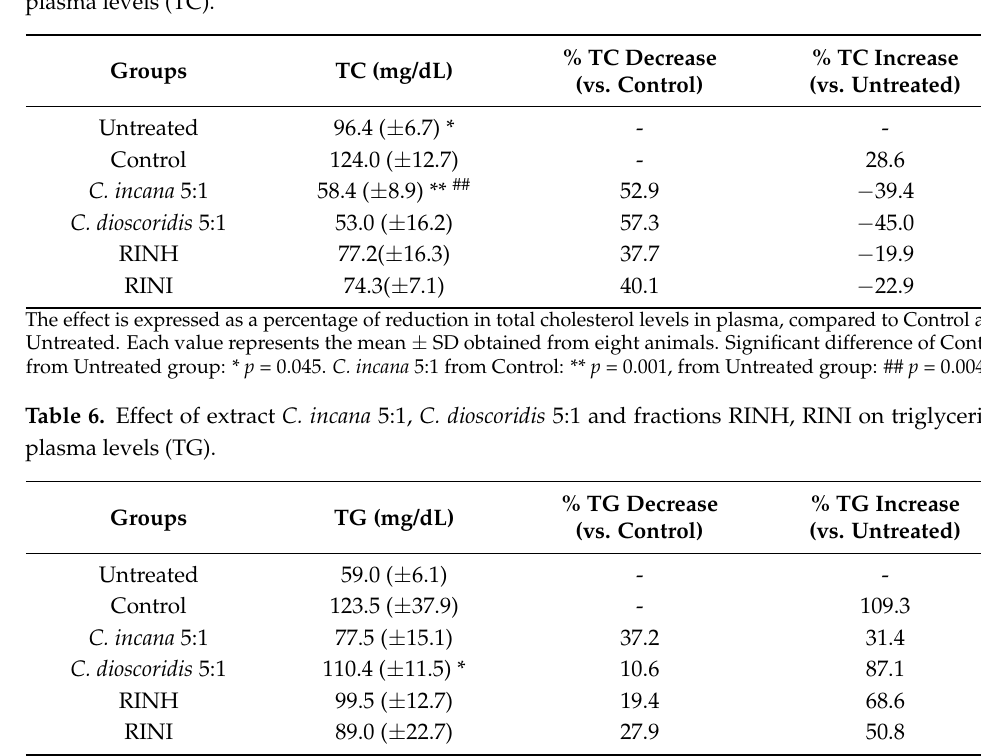
Table 5. Effect of extract C. incana 5:1, C. dioscoridis 5:1 and fractions RINH, RINI on total cholesterol plasma levels (TC).